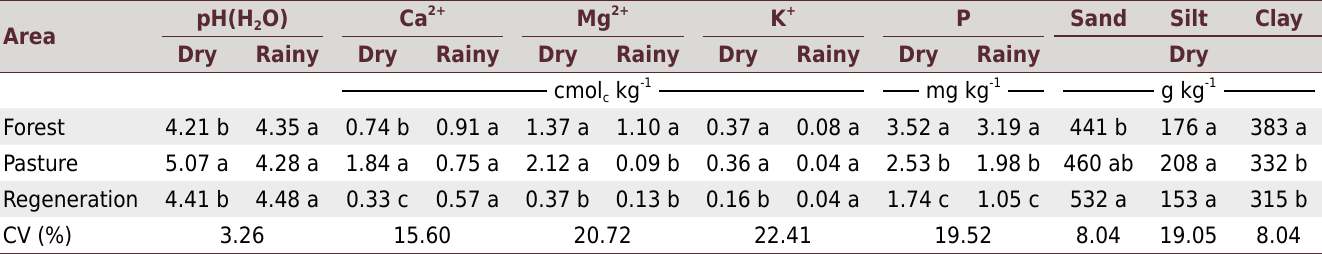
Means followed by the same uppercase letter in a row and the same lowercase letter in a column do not differ statistically (Bonferroni t test,